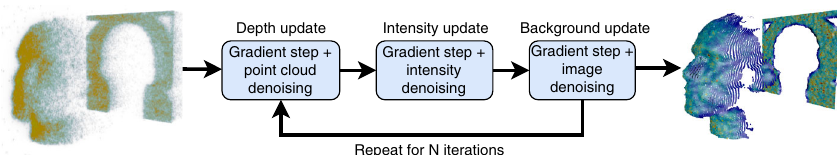
Fig. 2 Block diagram of the proposed real-time framework. The algorithm iterates between depth, intensity and background updates, applying a gradient step followed by a denoiser. Each step can be processed very quickly in parallel, resulting in a low total execution